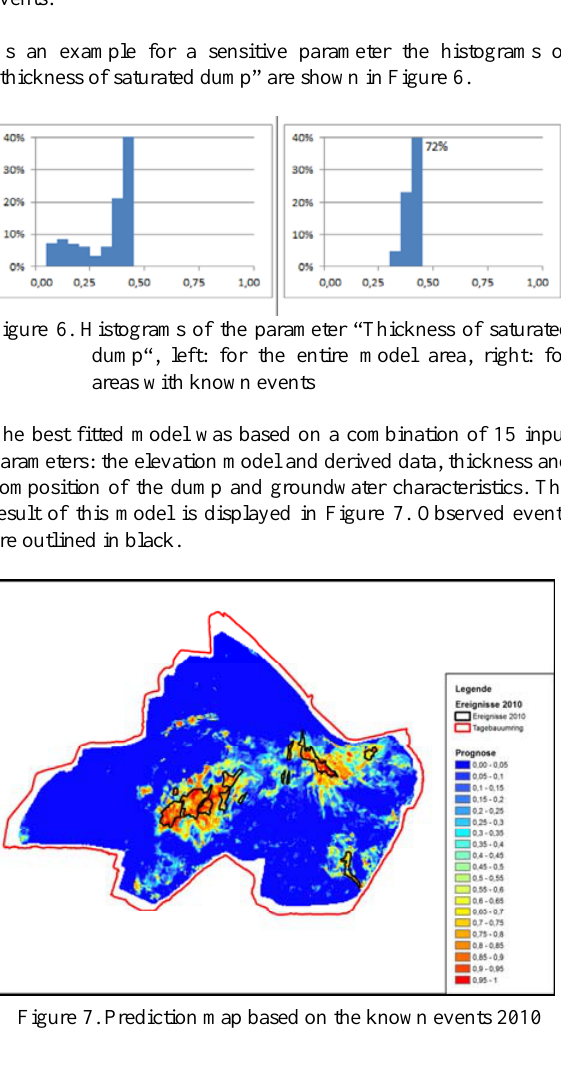
Figure 5. Scheme of model configuration